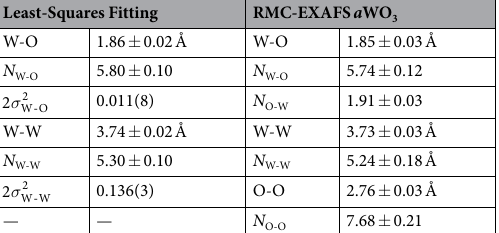
factors and the amplitude reduction factor S 02 to provide average values of atomic coordination [ N W-O , N W-W ]. To the contrary, atomic coordinations [ N W-O , N W-W ] computed directly from ab - initio MD structures of a WO 3 cor- respond to the average over a large ensemble of configurations with different scattering-paths, σ 2 and S 02 factors. Since the S 02 factor entering equation (2) is completely correlated with N W-O , N W-W16 , a small variation in S 02 could lead to large variation in N W-O , N W-W . Thus, differences between the experimental χ k k ( ) 3 , FT χ k k ( ) 3 and ab - initio FMS computed χ k k ( ) 3 , FT χ k k ( ) 3 spectra could possibly be ascribed to structural correlations with the S 02 MD MD factor and approximations on the muffin-tin radii for the potential of the photoabsorbing W atoms 14, 16, 17 . The RMC-EXAFS refinement Fourier transformed into the real-space FT χ k k ( ) 3 of the W-O and W-W RMC coordination shells in the experimental FT χ k k ( ) 3 spectrum was calculated according to (5) to the experimental FT χ k k ( ) 3 spectra reproduces Spectral fitting from RMC-EXAFS refined FT χ k k ( ) 3 RMC the real-space position of the first [W-O] and second coordination shells [W-W], and the multiple-scattering contributions observed in the experimental spectra. These results confirm that the atomic short-range order of a WO 3 , can be properly extracted through RMC-EXAFS simulations based on ab - initio FMS approaches [Fig. 1b, Real and Im components at the bottom]. Table 1 summarizes the main interatomic bond-distances, atomic coor- dination and σ 2 factors, obtained from nonlinear least-squares spectral fitting of the measured χ k k ( ) 3 , FT χ k k ( ) 3 spectra, and those calculated directly from the RMC-EXAFS optimized structures of a WO 3 . The data show an excellent agreement to each other, which confirms that averaging over non-equivalent WO x atomic-environments yields accurate reproduction of the χ k k ( ) 3 , FT χ k k ( ) 3 spectra and correlated structural parameters of a WO 3 . The σ 2 factors in Table 1 reflect the attenuation of χ k k ( ) 3 and FT χ k k ( ) 3 due to the mean-square static disorder in the distribution of interatomic bond-distances and ionic displacements 3 . Thus, the calculated values for σ 2 corre- spond to the degree of disorder in a WO 3 , which is mainly manifested in the shortening of interatomic bond-distances [W-O, W-W, O-O], and in the lowering of the atomic coordination [ N W-O , N O-W , N W-W , N O-O ], with respect to crystalline phases of WO 3 . To more quantitatively assess the atomic short-range order of our RMC-EXAFS optimized structure of a WO 3 we analyze the local bonding and coordination around the W and O atoms. The RMC-EXAFS optimized struc- tures of a WO ≈ 2.8 Å], 6,5,4 unit-blocks [Fig. 2a–d]. Distribution of atomic coordination [at a W-O bond-length cutoff of shows that W atoms hold mainly octahedra [ N W-O = 6, ≈ 76%], under coordinated pentahedra [ N W-O = 5, ≈ 22%], and tetrahedra [ N W-O = 4, ≈ 2%] locally bonding with neighbouring O atoms [Fig. 2e]. This results in a main atomic coordination N W-O ≈ 5.74 ± 0.12 in the first W-O shell, in agreement with the main value N W-O ≈ 5.8 ± 0.1 obtained from least-squares fitting of the χ k k ( ) 3 and FT χ k k ( ) 3 spectra. The O atoms hold nearly two-fold coor- dination with W atoms, N O-W ≈ 1.91 ± 0.10 [Fig. 2e]. The edge-sharing [O-W-O] and corner-sharing [W-O-W] bond-angle distributions show peaks at 94°, 161° and at 105°, 150° [Fig. 2f]. After refinements, all the RMC-EXAFS optimized structures of a WO 3 attained a similar atomic-bonding distribution and displayed small variation in the atomic coordination and bond-angle distributions. This is of course, due to the use of pre-converged MD trajectories, and the structural constraints applied in simulations, which force the input struc- tures to achieve a similar atomic short-range order to properly fit the χ k k ( ) 3 and FT χ k k ( ) 3 spectra [see Methods]. Interatomic bond-lengths were almost the same. Some structures displayed over-coordinated WO 7 -units at larger W-O bond-length cutoff [ ≈ 3.12 Å]. However, atomic coordinations N W-O = 5,6 dominates accurately the struc- tural characteristics of the EXAFS spectra of a WO 3 . Here the reported structural correlations and physical quan- tities correspond to the average over twelve RMC-EXAFS optimized structures of a WO 3 . To compare our results with X-ray and neutron diffraction experiments, the atomic short-range order of our RMC-EXAFS optimized structures of a WO 3 was further analyzed in terms of the structure factor S ( Q ), defined according to